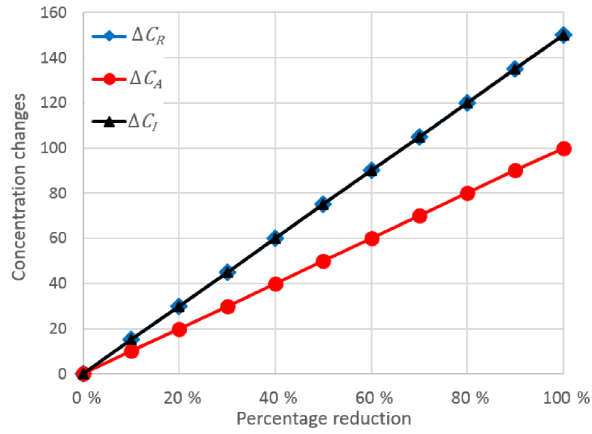
Figure 3. Evolution of the concentration changes resulting from dif- ferent percentage of source abatement (top-down approach) for the three sectors (residential, agricultural and